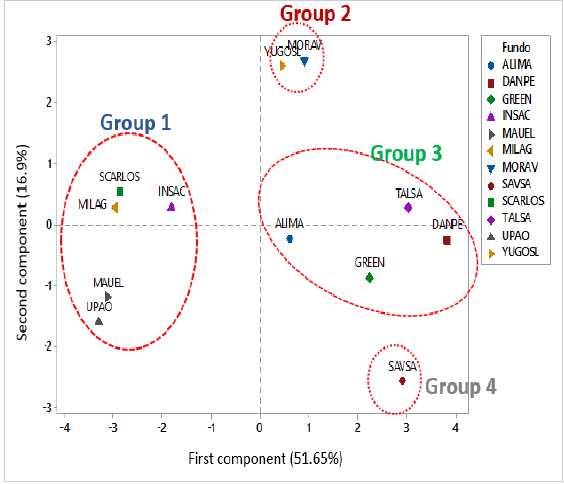
Figure 1. Biplot graph of the main components of the asparagus fields of the Chavimochic irrigation project in 2017.